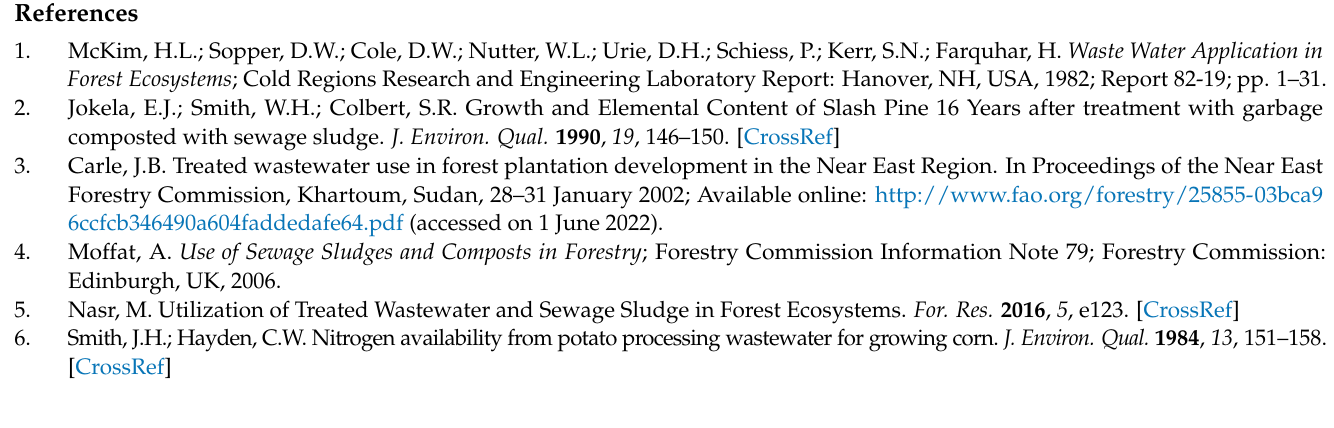
Table S1: Description of study plots. Table S2: The basic dendrochronological statistics of tree-ring width chronologies of Scots pine for the different research